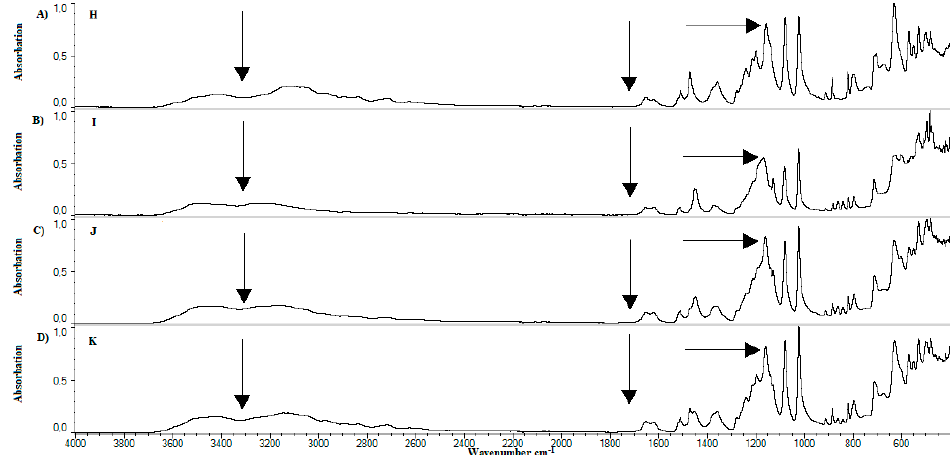
Figure 10. Comparison of Spectrum FTIR for samples H–K. ( A ) Sample H; ( B ) sample I; ( C ) sample J; ( D ) sample K.